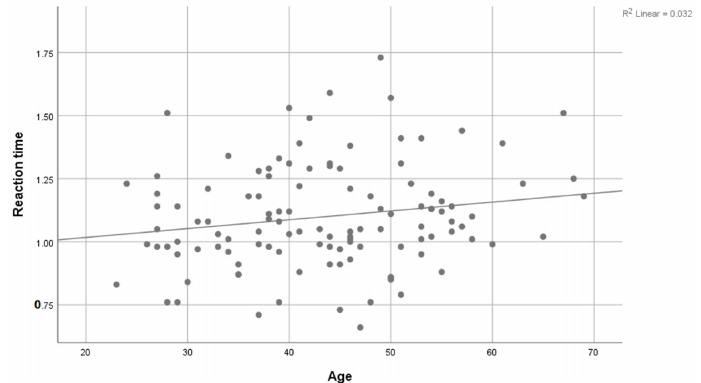
Figure 7. Scatter plot of dependence of reaction time on driver’s age. Source: own collaboration. In addition, we applied cluster analysis to form groups of drivers that have a similar reaction time. We used Ward’s clustering method and the square Euclidean distance be- tween cases. The result is visualized in a dendrogram showing the hierarchical clustering of drivers (Figure A1 in Appendix A). We chose a step with four clusters of drivers created based on their reaction time from the created solutions. The choice of three or five clusters would yield very similar results in further analysis of the drivers’ age in these clusters. Subsequently, based on the affiliation of each driver to the cluster, we compared the ages of drivers in the clusters. We assumed that if the reaction time of the driver changes, or even increases, with increasing age, then drivers with similar reaction times in one cluster would have approximately the same age. Conversely, drivers assigned to different clus- ters due to their different reaction times should differ in age. Figure 8 shows the ages of the drivers in the individual clusters, where a slight increase in age among the clusters is visible.